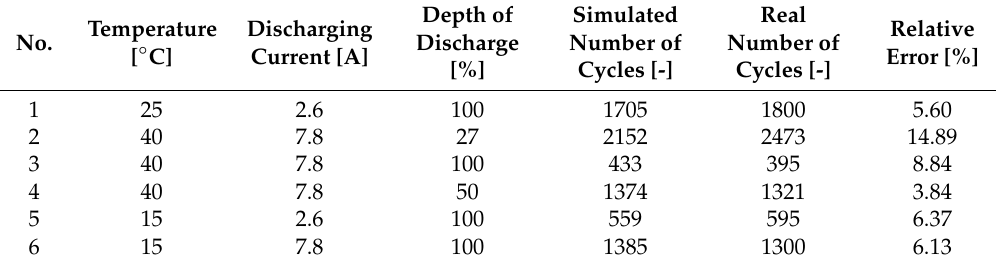
Table 5. Verification results of NMC cell wear from fuzzy model 273